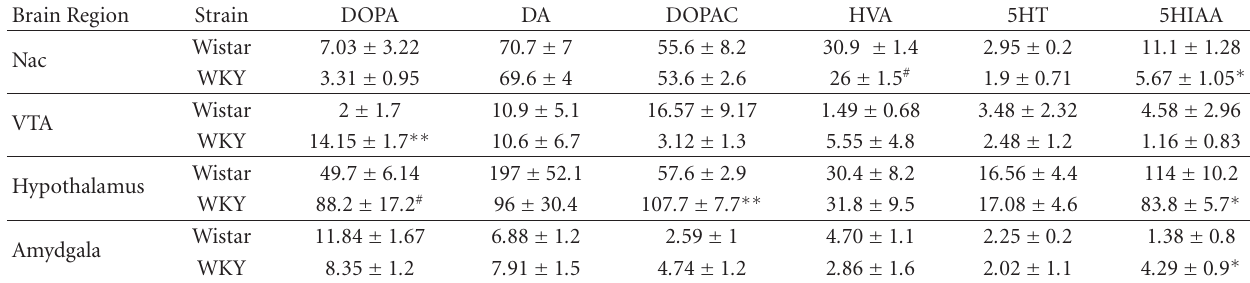
Table 1: Mean basal levels of monoamines and their metabolites in the four di ff erent limbic brain regions ( ± SEM) of 34-35 day old Wistar and WKY rats (pmol/mg protein).